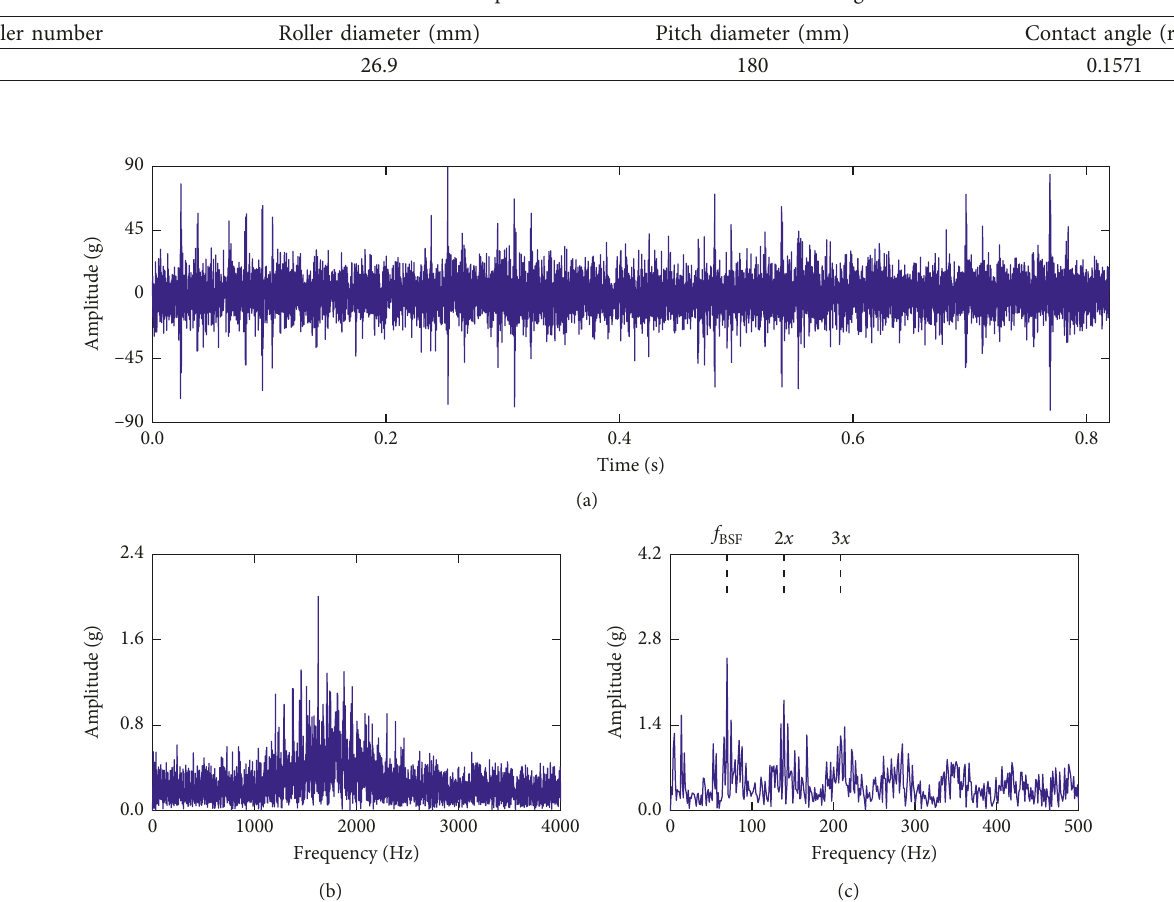
Table 2: Geometric parameters of the fault wheelset bearing.